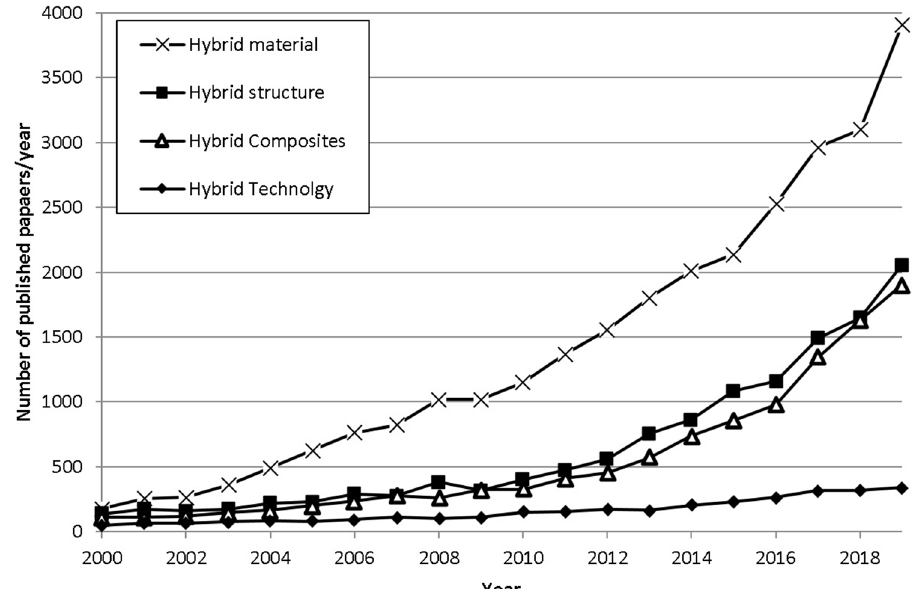
Fig. 1. Statistical data of number of published papers, by “ Hybrid structure ” , “ Hybrid material ” , “ Hybrid Composites ” and “ Hybrid Technology ” keywords. Data source (cid:1) ScienceDirect ® , by Elsevier B.V.